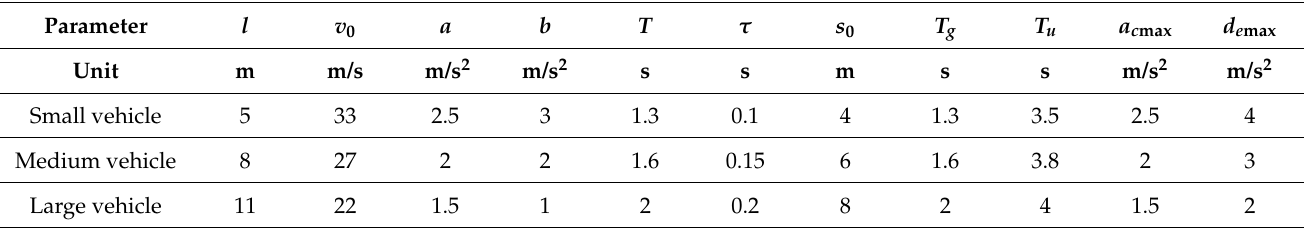
Table 2. Parameter values of different types of